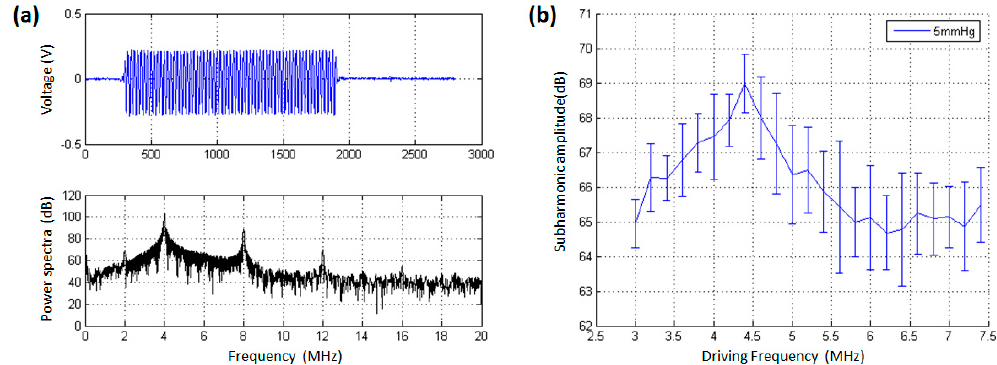
Figure 7. The effect of driving frequency on the subharmonic scattering power from SonoVue microbubbles at 13 min after injecting them. ( a ) An example of the received scattering signals from microbubbles and the corresponding power spectrum. A 64 cycles tone burst was transmitted at the driving frequency of 4 MHz. ( b ) The subharmonic scattering power as a function of driving frequency. The overpressure was 5 mmHg.